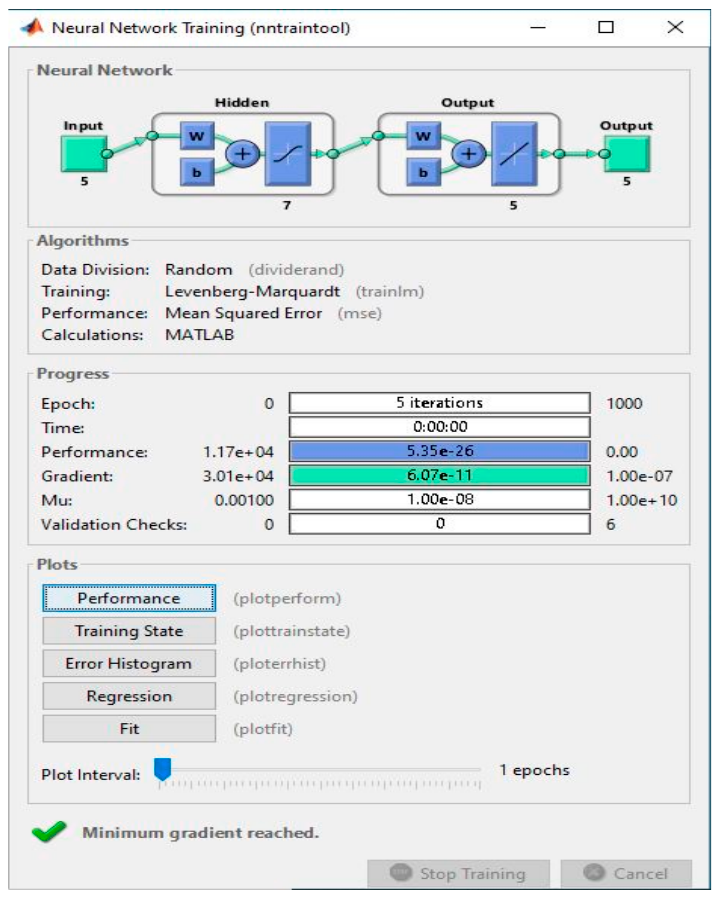
Figure 2. The training for the ANN network.